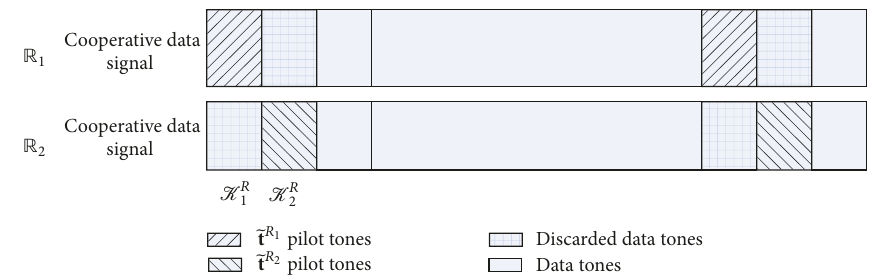
Figure 3: Sketch of the structure in the frequency domain for Scheme